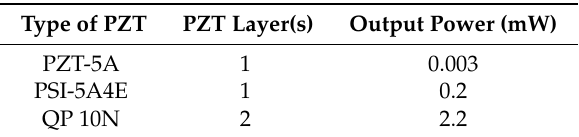
Table 1. Power generated by various piezoelectric (PZT) aeroelastic energy harvesters (PAEHs) based on flutter mechanism